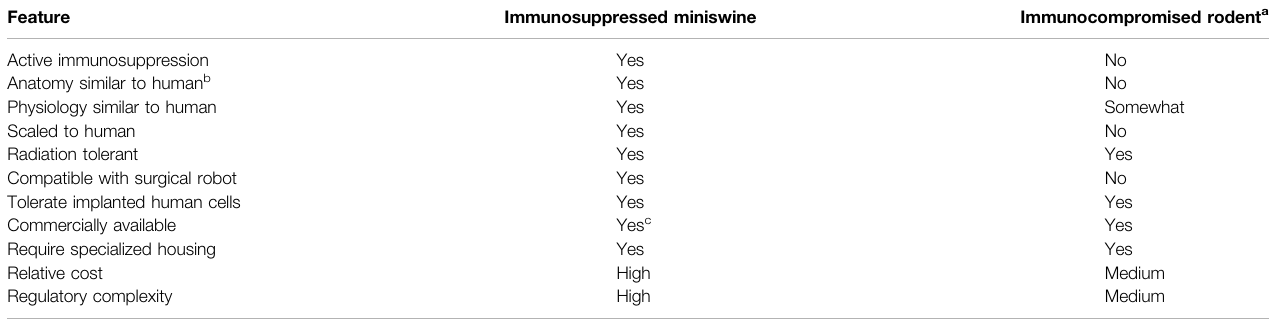
TABLE 2 | Comparison of emerging miniswine and classical rodent model for testing salivary